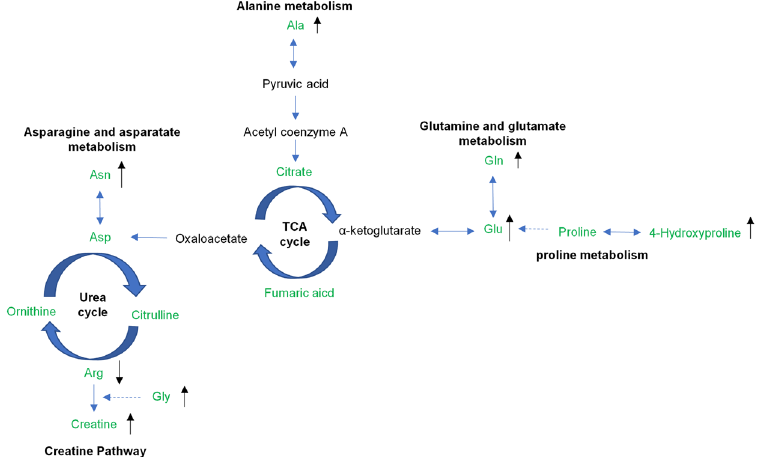
Figure 3. Amino acid and derivates change in mature milk of sows. The metabolites marked in green were detected by GC-MS/LC-MS platform. The differential metabolites are shown with